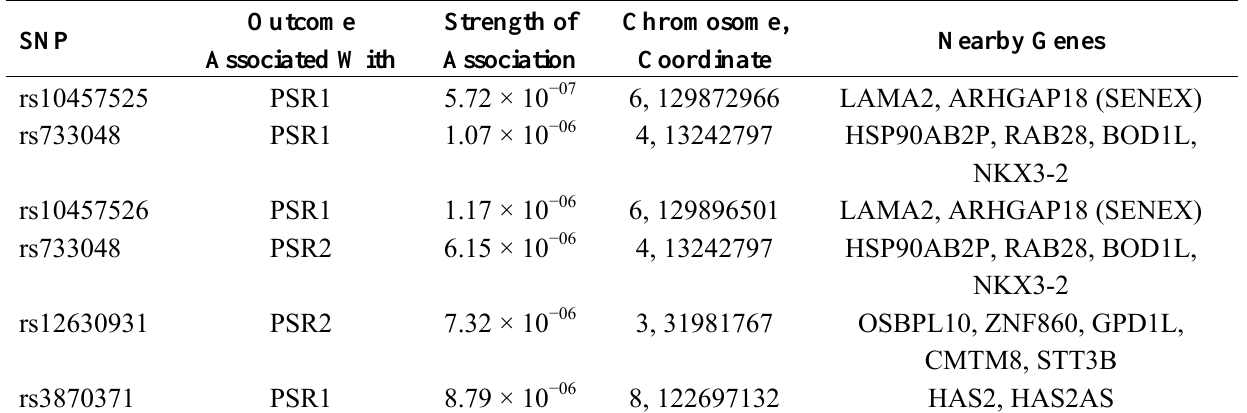
Table 2. Genotyped SNPs identified by